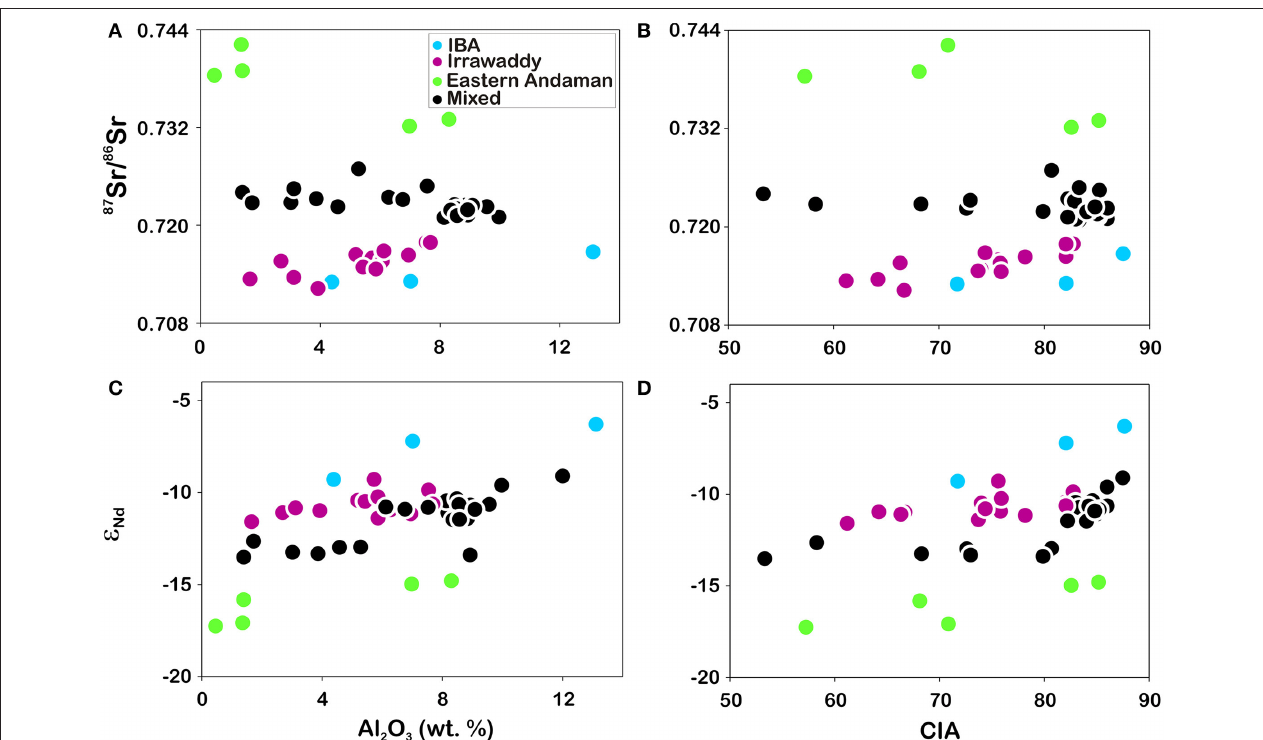
FIGURE 5 | Scatter plot of 87 Sr/ 86 Sr and ε Nd with Al 2 O 3 (wt. %; A,C) and CIA (B,D) of the shelf sediments. The absence of any correlations ( r = 0.04–0.5 for n = 46) among them suggests that Sr and Nd isotope compositions of these sediments are not influenced by size sorting and chemical weathering and hence can be used as good proxies to constrain their